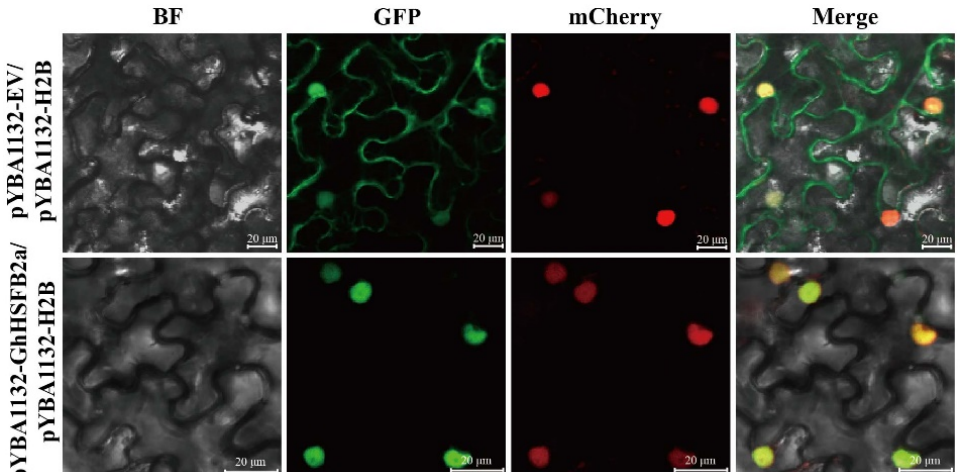
Figure 3. Subcellular localization of GhHSFB2a. Agrobacteria carrying the pYBA1132- green fluorescent protein ( GFP ) or pYBA1132 -GhHSFB2a-GFP vector were inserted into the leaves of four-week-old N. benthamiana plants expressing the nuclear-localized marker H2B-mCherry. BF, the bright field. GFP protein was localized both in cytoplasm, plasma membrane and in the nucleus, and GFP-fused GhHSFB2a protein was localized in the nucleus. Results were visualized using a confocal microscopy 48 h after transformation. Bars = 20 μ m.